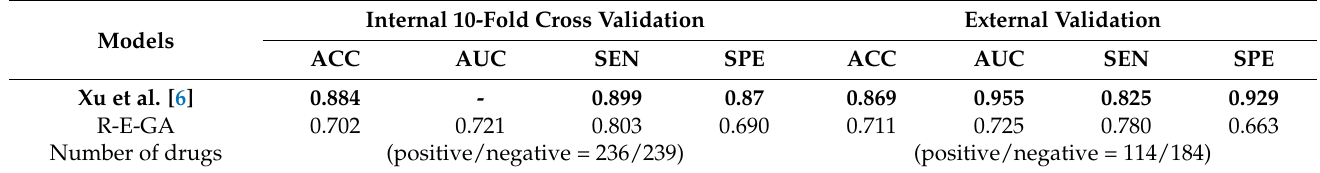
Table 5. Performance of external validation datasets training by Combined dataset with molecular One-hot Encoded